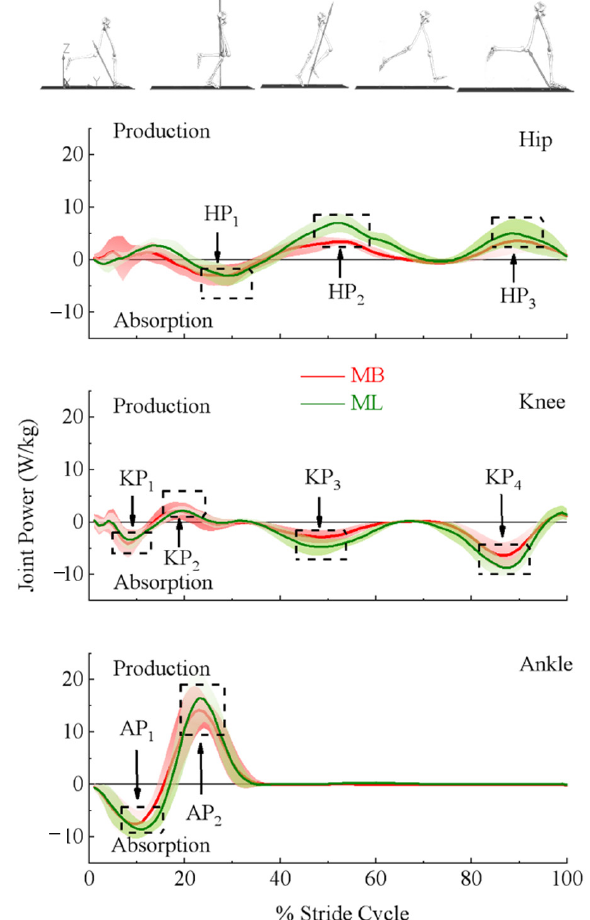
Figure 2. Labeled here are the outcome variables used to quantify the differences in the lower ex- tremity joint powers of the hip (top panel), knee (middle panel), and ankle (bottom panel) (denoted under the ensemble power curve estimated by marker-based (MB) (red) and markerless (ML) (green) motion capture systems). Joint powers were scaled to participants’ body mass.